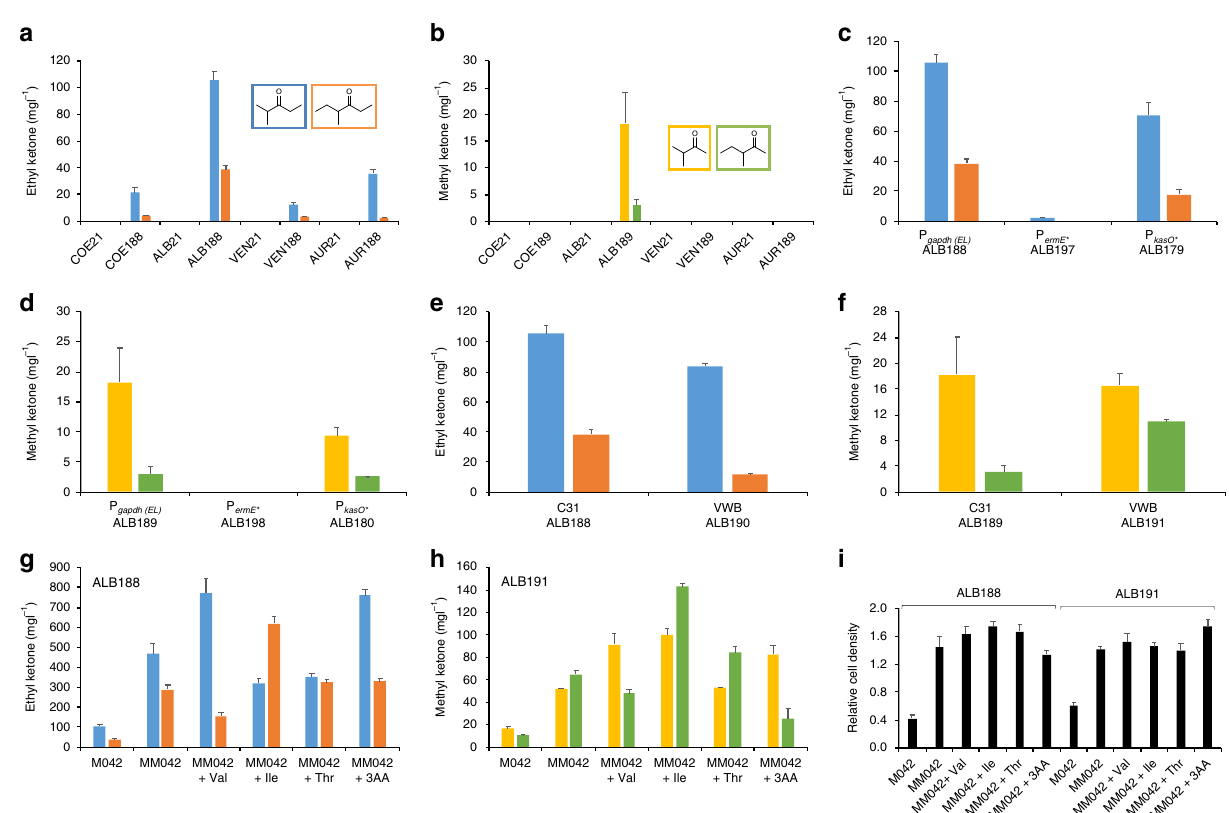
Fig. 2 Short-chain ketone production in engineered Streptomyces strains. Unless otherwise noted, each strain was cultured in Medium 042 (M042) for 5 days at 30 °C and short-chain ketone production was measured by liquid chromatography time-of- fl ight mass spectrometry. Error bars are the S.D. from three independent experiments. mCherry encoding strains (COE21, ALB21, VEN21, and AUR21) were used as a negative control. a Ethyl ketone production from 4 different Streptomyces hosts (COE188, ALB188, VEN188, and AUR188). 2-Methyl-3-pentanone and 4-methyl-3-hexanone are shown in blue and orange, respectively. 4-Methyl-3-hexanone was quanti fi ed as 5-methyl-3-hexanone equivalent because 4-methyl-3-hexanone is not commercially available. b Methyl ketone production from four different Streptomyces hosts (COE189, ALB189, VEN189, and AUR189). 3-Methyl-2-butanone and 3- methyl-2-pentanone are shown in yellow and green, respectively. c Three different promoters (P gapdh ( EL ) , P ermE* , and P kasO* ) were compared for ethyl ketone production in S . albus (ALB188, ALB197, and ALB179). d Three different promoters were compared for methyl ketone production in S . albus (ALB189, ALB198, and ALB180). e Two different genome locations (speci fi c attB sites for Φ C31 and VWB) were compared for ethyl ketone production in S . albus (ALB188 and ALB190). f Two different genome locations were compared for methyl ketone production in S . albus (ALB189 and ALB191). g Ethyl